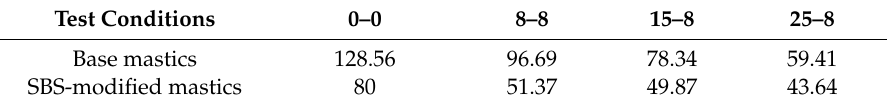
Figure 14. Distribution frequency of the mastic surface heights. ( a ) Base mastics; ( b ) SBS- modified mastics. Table 7. Surface height of the samples under different test conditions (nm).